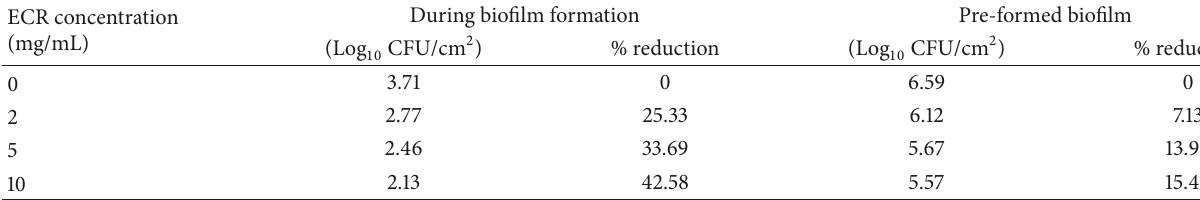
Table 2: Effect of extract of the leaves of C. regium treatment on Cryptococcus gattii (ATCC 56990) biofilms.